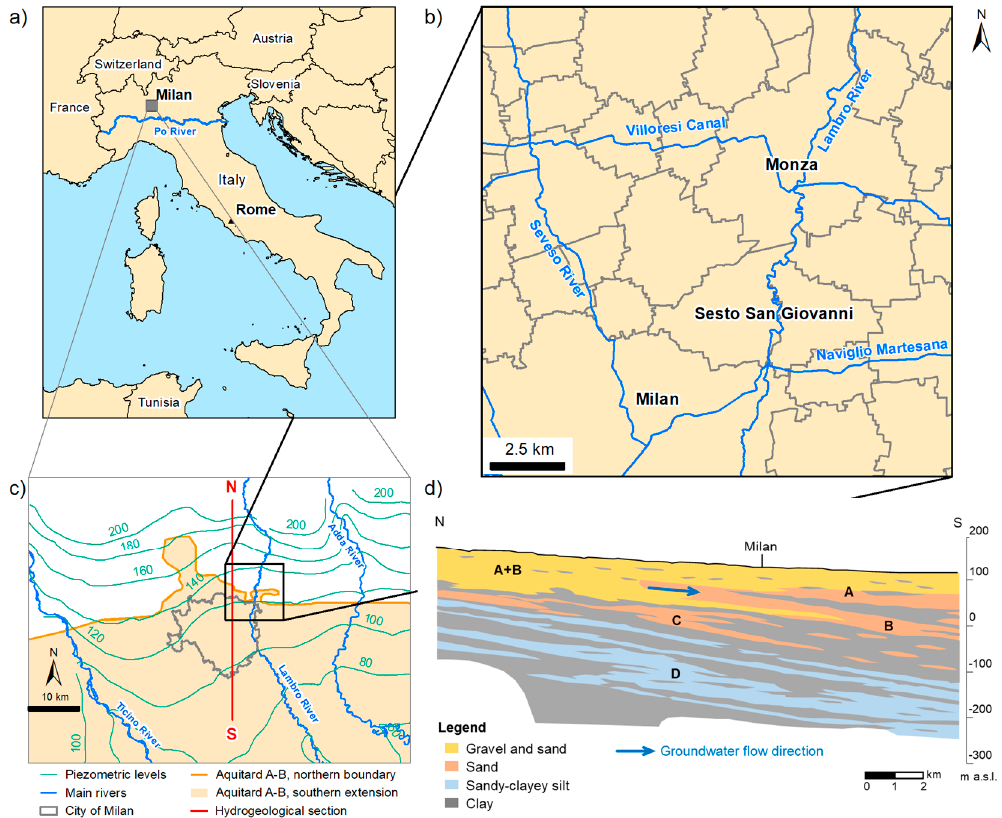
Figure 1. ( a ) Location of the study area (grey square); ( b ) study area with municipality borders, main rivers, and canals. Milan, Sesto San Giovanni, and Monza are the main cities in the study area. ( c ) Piezometric levels of the shallow aquifer (m a.s.l.). The golden line approximates the northern border of the aquitard: the main shallow aquifers (A and B in the hydrogeological section) are hydraulically divided southwards (golden area), whereas the aquifers are not separated northwards (A + B in the hydrogeological section); ( d ) north-south hydrogeological section.